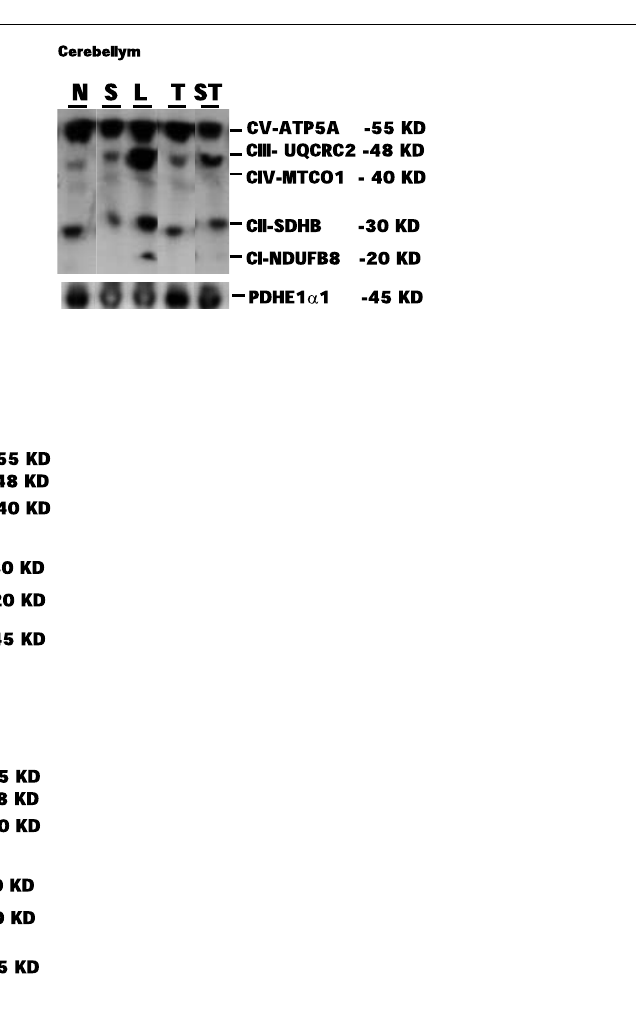
FIGURE 4 | Representative samples ofWestern blotting of CI, CII, CIII, CIV, CV, and PDHE1 α 1 protein bands in the tissue homogenates of rat prefrontal cortex (PFC), cerebellum, hippocampus, and cerebral cortex collected at 7days post mTBI . Contralateral and ipsilateral hippocampus and cerebral cortex were collected for mTBI and